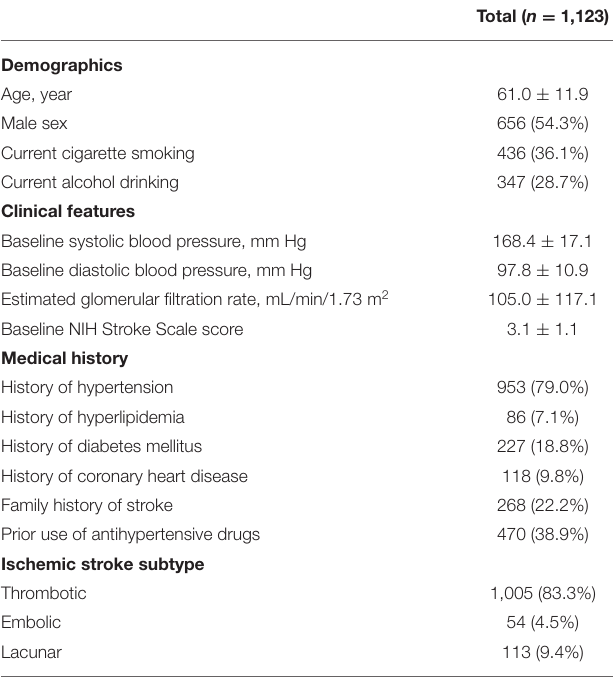
TABLE 3 | Baseline characteristics of ischemic stroke